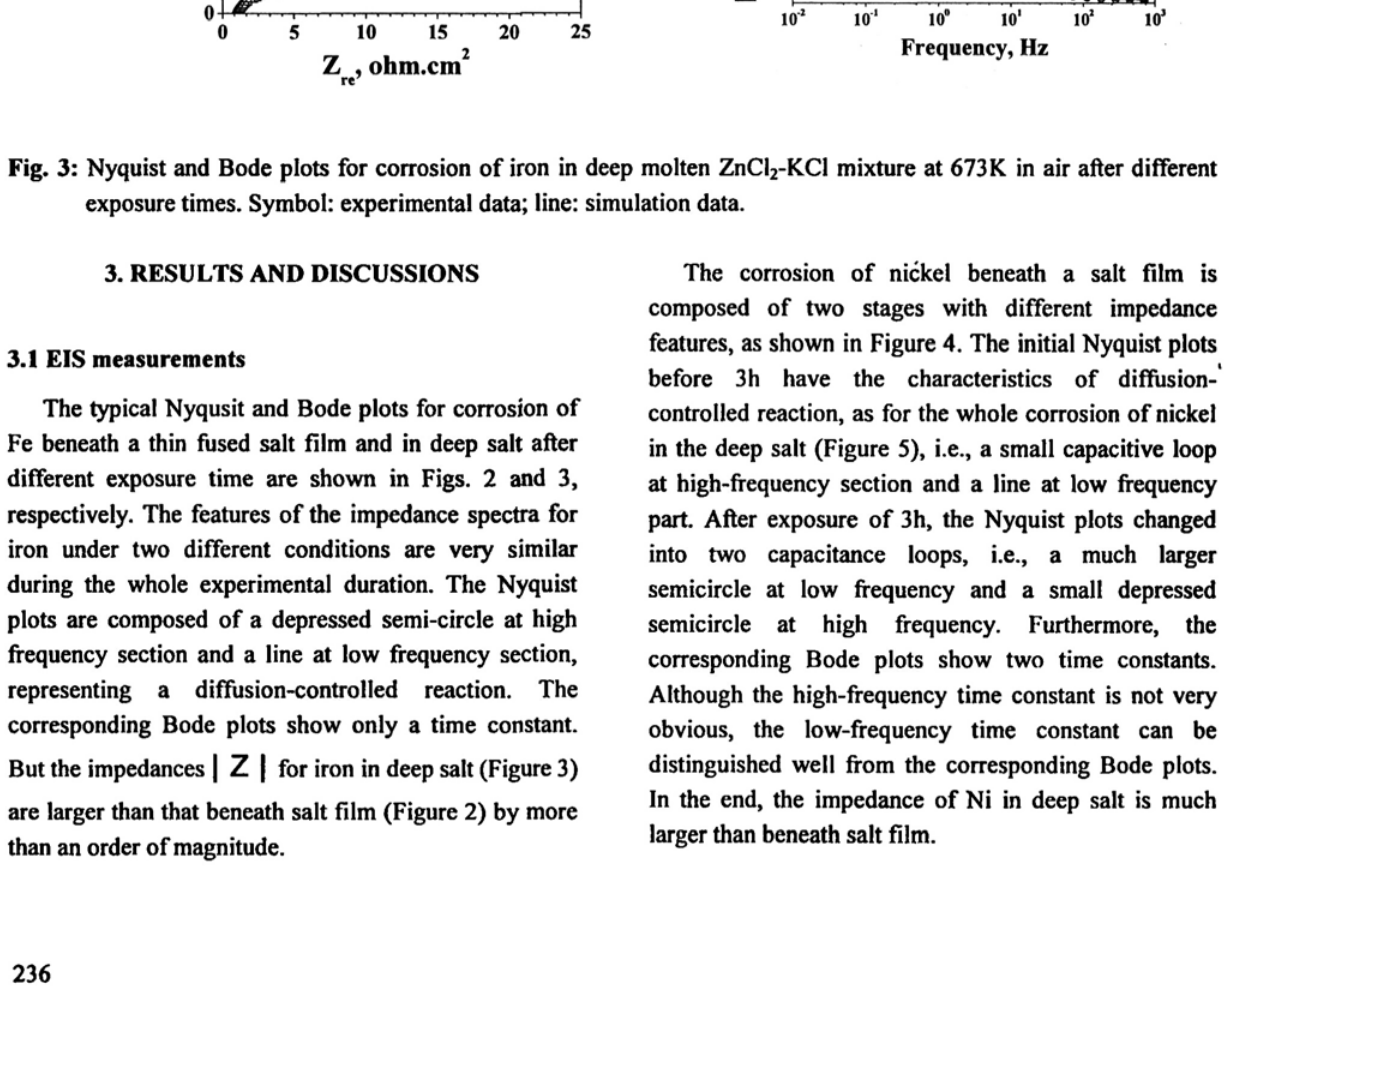
-KCl mixture at 673 K in air after different 2